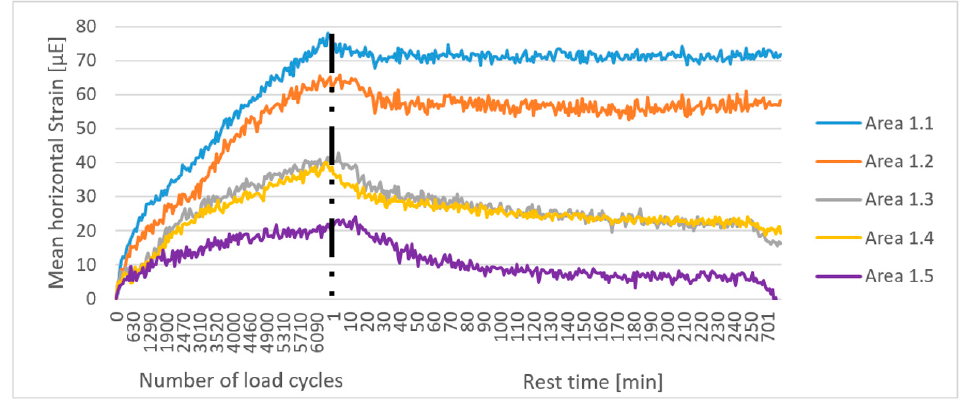
Figure 7. Five areas on the microcrack 1 of specimen S1 during the second step (healing), ( a ) 0 min, ( b ) 32 min, ( c ) 360 min.